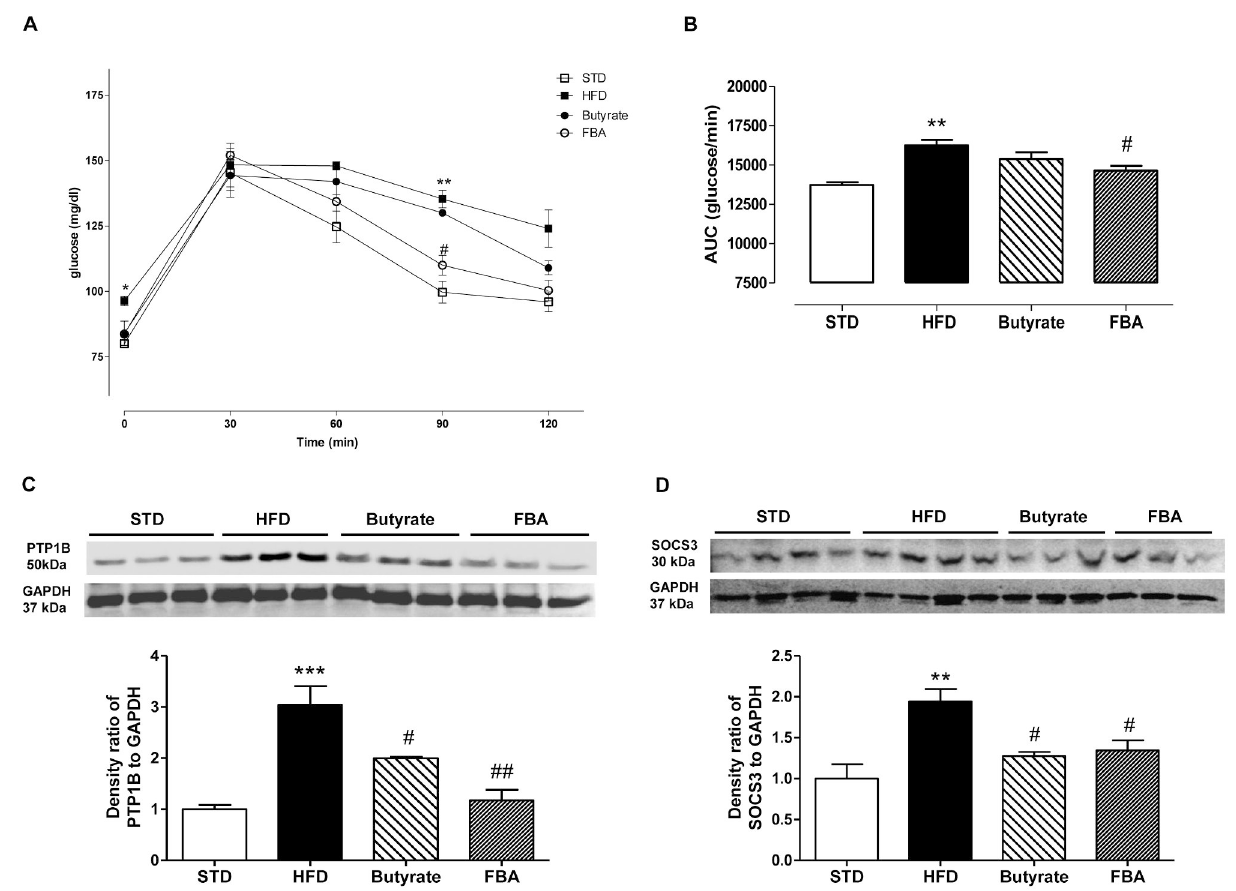
Figure 4. Effect of butyrate and FBA on glucose homeostasis and insulin resistance. Glucose tolerance test (A) in STD and HFD-fed rats (n=6, each group) was performed and AUC evaluated (B). Panels C and D show representative Western blot analysis of PTP1B and SOCS3 expression from liver tissue, respectively (n=6 each group). **P<0.01, ***P<0.001 vs STD; # P<0.05, # # P<0.01 vs